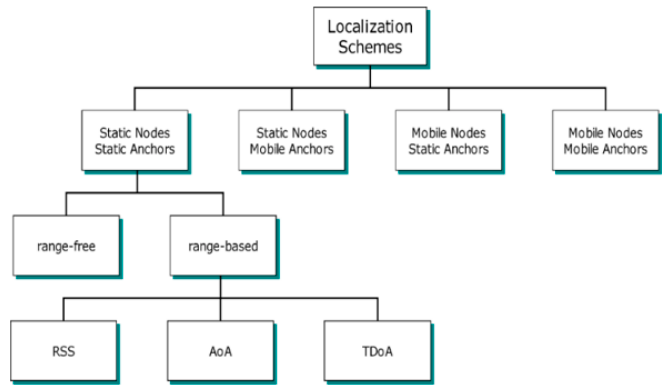
Figure 2. Classification of localization schemes in WSNs [17].